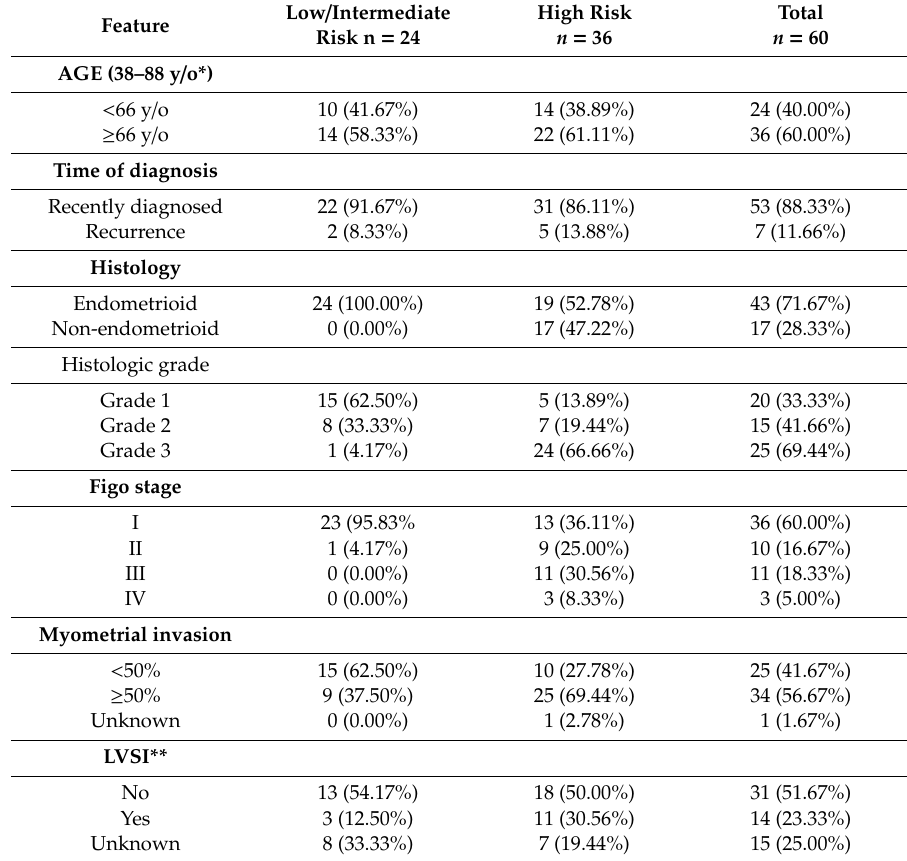
Table 1. Clinicopathologic characteristics of the cohort of endometrial cancer